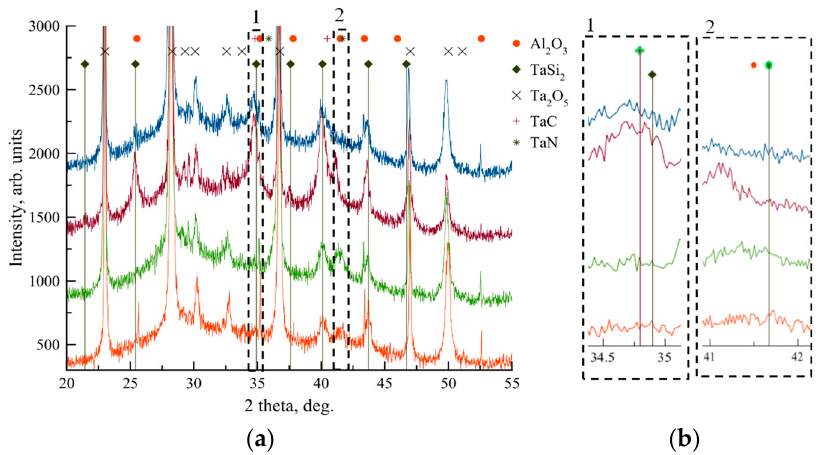
Figure 9. XRD patterns of coatings 2 (5 sccm N 2 ), 3 (10 sccm N 2 ), 4 (5 sccm C 2 H 4 ), and 5 (10 sccm C 2 H 4 ) after annealing at 1200 °C for 10 min: overview diffractograms ( a ) and enlarged areas ( b ).